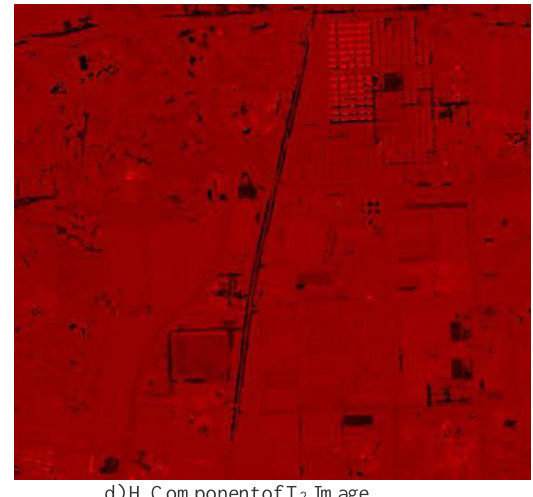
Figure 2. Effect Contrast of Two H Components after IHS Transform